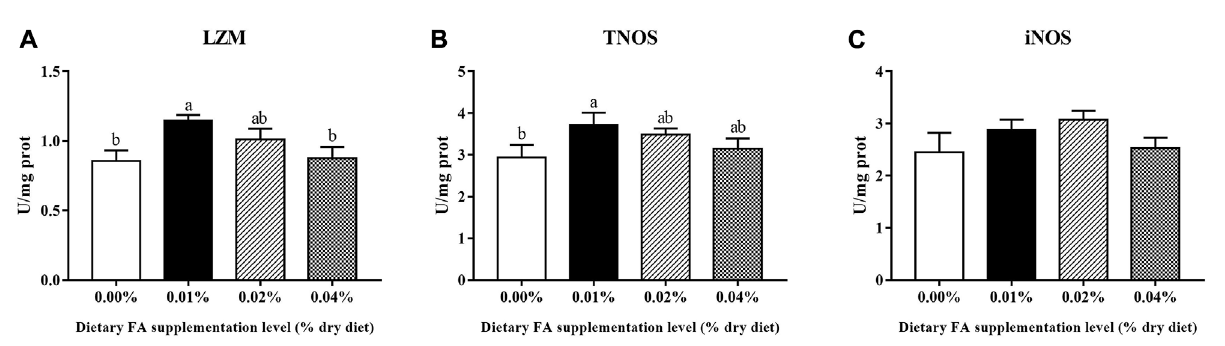
FIGURE 4 Effects ofsupplementalfulvicacid on LZM (A) ,TNOS (B) andiNOS (C) activities inthevisceral massoflarge yellow croaker larvae (mean± S.E.M, n= 3). LZM, lysozyme; TNOS, total nitric oxide synthase; iNOS, inducible nitric oxide synthase. Bars with different letters showed a signi fi cant difference ( p < 0.05, Tukey ’ s test).